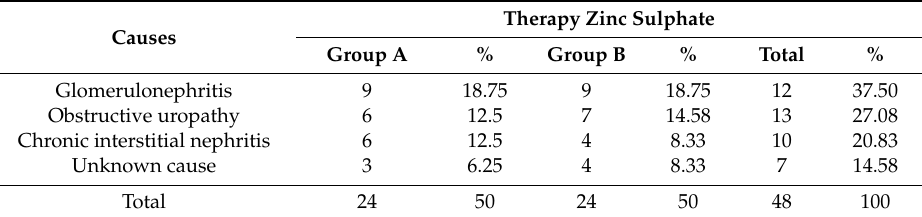
Table 2. Causes of chronic kidney disease in this series ( n =